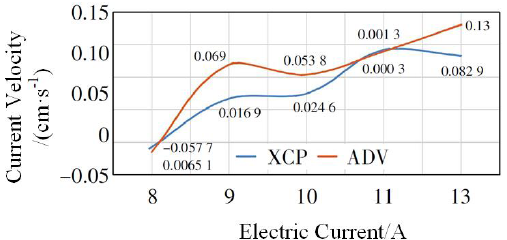
Figure 18. Comparison of ADV and XCP